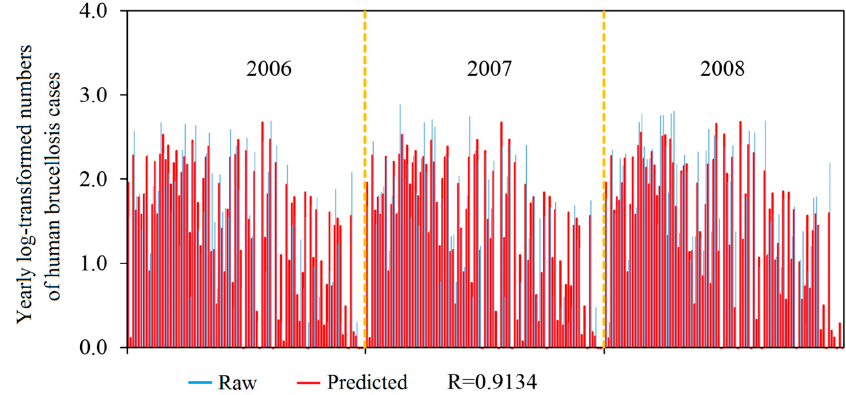
Figure 3. Comparison between predicted (red) and raw yearly log-transformed numbers of human brucellosis cases (blue) at the county level in the model development phase. X -axis denotes counties, with 89 counties listed horizontally in the same order in all three panels (2006, 2007 and 2008).